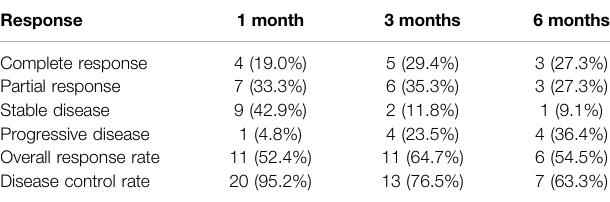
TABLE 4 | Local tumor response assessed using mRECIS criteria.